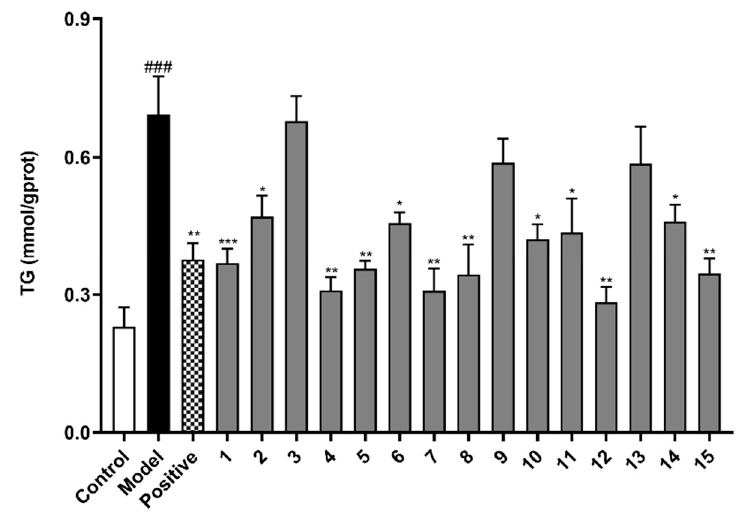
Figure 5. The effects of compounds ( 1 – 15 ) on triglyceride (TG) level in FFA-induced BRL cells. BRL cells were treated with a mixture of 0.5 mM FFA in the absence or presence of compounds ( 1 – 15 ) at a concentration of 10 µ M. The values are presented as mean ± SEM of six independent experiments. ### p < 0.001, vs. the control group; * p < 0.05, ** p < 0.01, *** p < 0.001, vs. the model group.